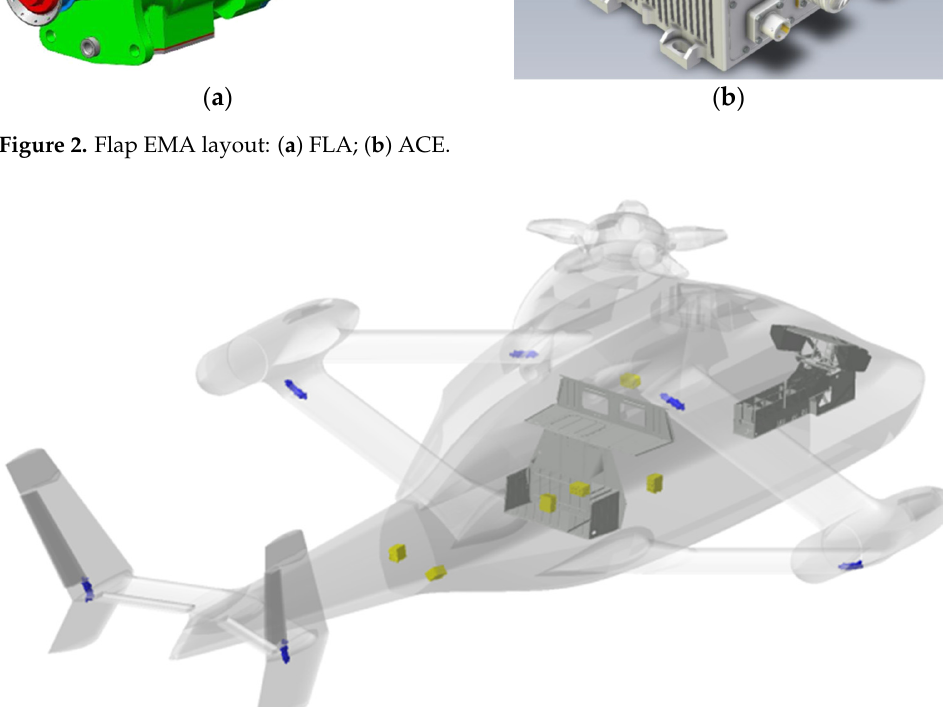
Figure 3. Locations of the EMA parts on the RACER helicopter-plane (yellow: ACEs; blue: FLAs).